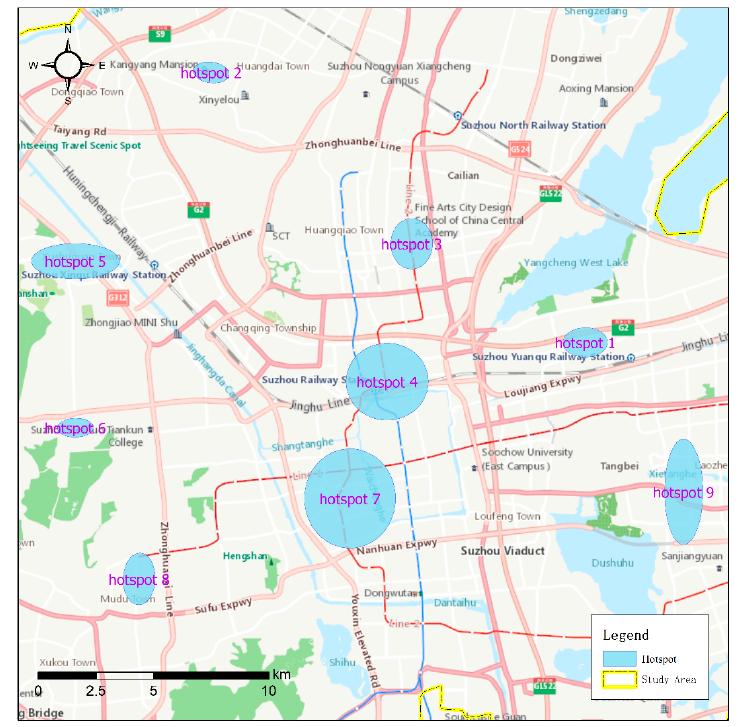
Figure 2. Hotspot thumbnail.